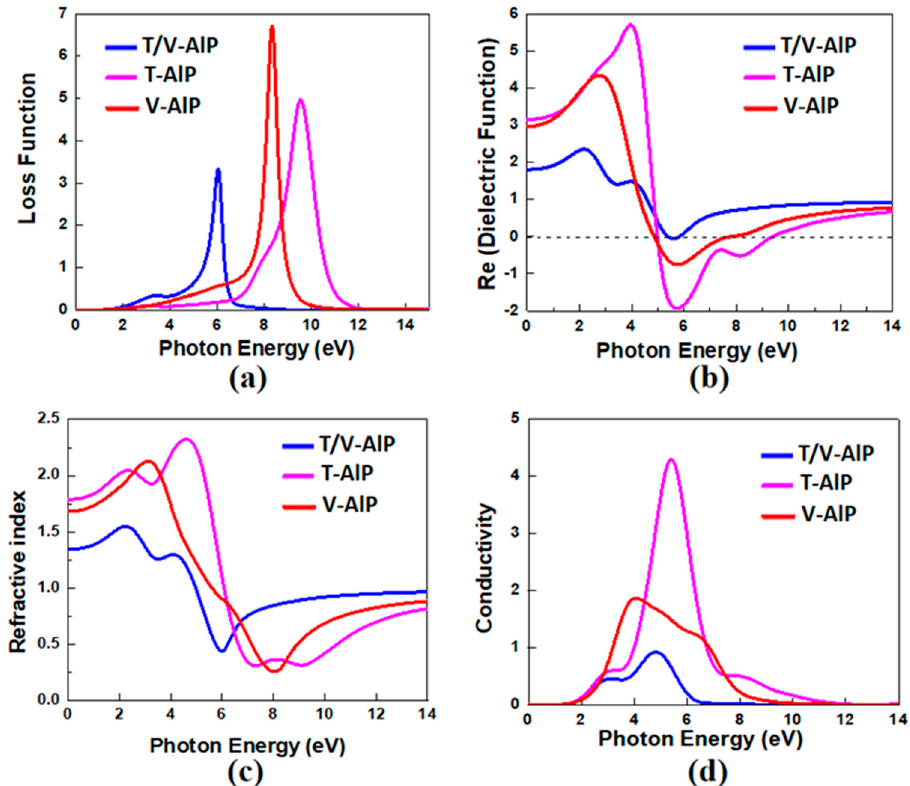
Figure 11. ( a ) The loss function; ( b ) the real part of dielectric function; ( c ) the refractive index and ( d ) the conductivity of the three types of AlP bilayers.